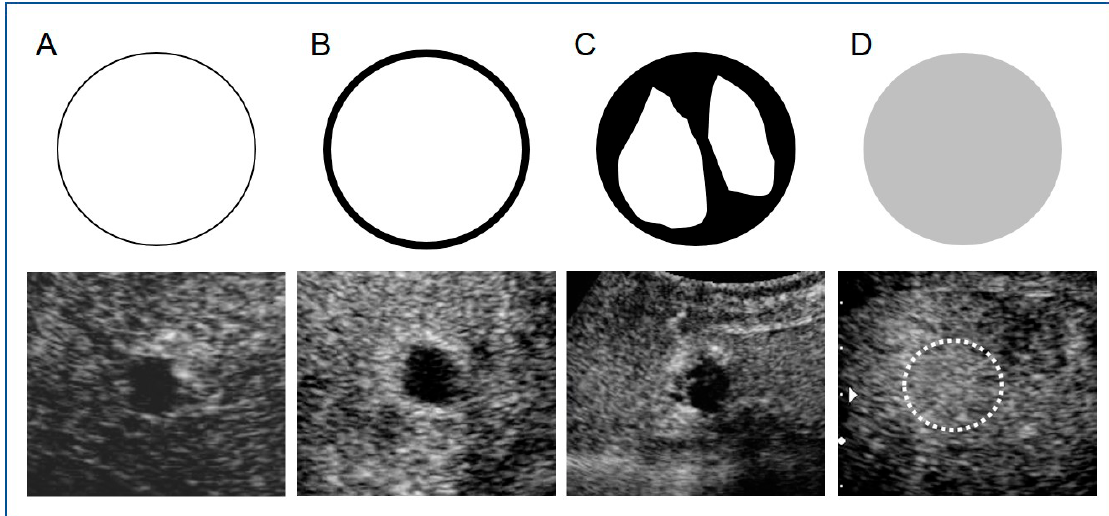
Figure 1. Diagrams and images of vascular enhancement patterns on contrast-enhanced ultrasound (CEUS) using Sonazoid ® within 3 days after transarterial chemoembolization with drug-eluting beads (DEB-TACE) for hepatocellular carcinoma (HCC). Upper images are diagrams and lower images are actual CEUS images of cases in this study. A : No enhancement; B : Peripheral ring enhancement; C : Partial enhancement within or peripheral tumors; D : Reduced or unchanged enhancements in whole tumors. (This CEUS image is a reduced enhancement in whole tumor (in white dot circle).